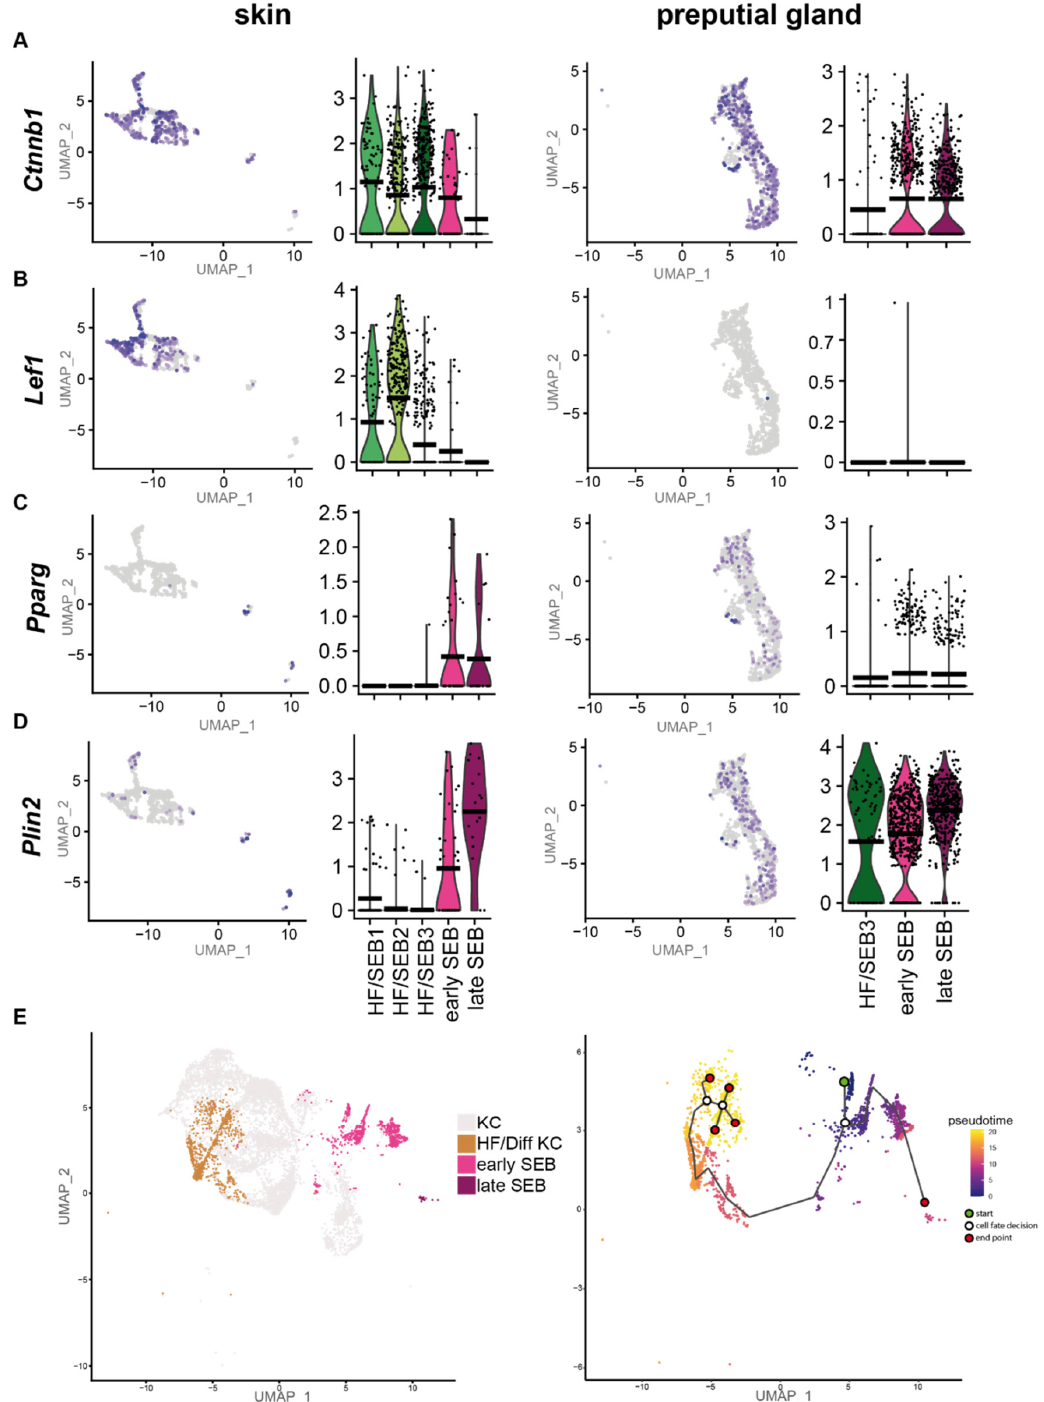
Figure 3. Preputial gland sebocytes lack downstream effector genes relevant for HF/SG lineage decisions. Featureplots and violin plots of the integrated sebocyte subcluster from skin and preputial gland showing the expression of ( A ) β -catenin ( Ctnnb1 ), ( B ) Lymphoid enhancer-binding factor-1 ( Lef1 ), ( C ) Peroxisome proliferator-activated receptor gamma ( Pparg ), ( D ) Perilipin 2 ( Plin2 ). Violin plots show gene expression levels and crossbar of violin plots depicts mean expression value. Vertical lines show maximum expression. The width of violins represents the frequency of cells at the corresponding expression levels. ( E ) UMAP-plot and pseudotime trajectory track starting from Blimp + sebocyte precursors (green circle). Color code indicates computational calculated progression in differentiation. White circles indicate cell fate decision checkpoints and red circles depict differentiation endpoints.